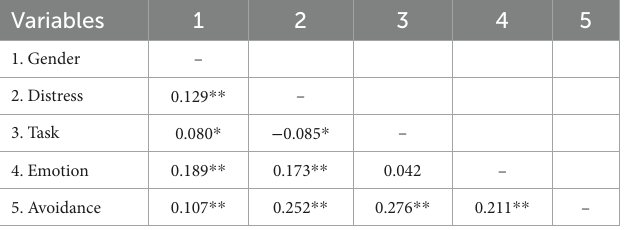
TABLE 2 Point-biserial correlation between coping strategies and